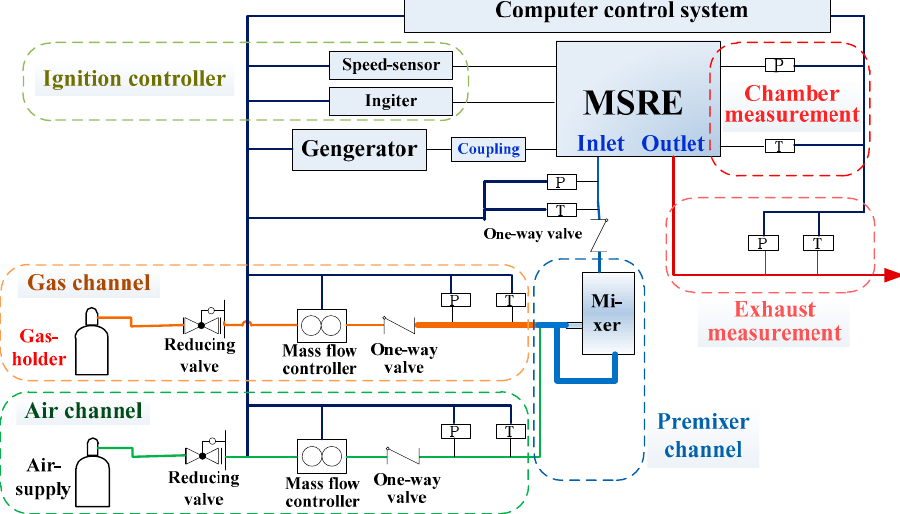
Figure 24. The experimental platform for MSRE.